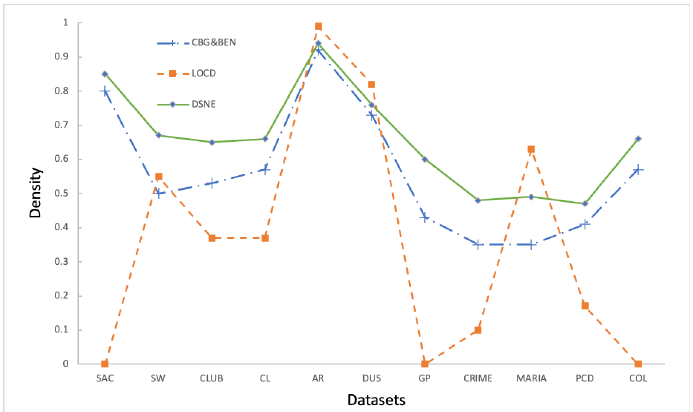
Figure 9. Experimental results of three algorithms evaluated by D in 11 datasets.